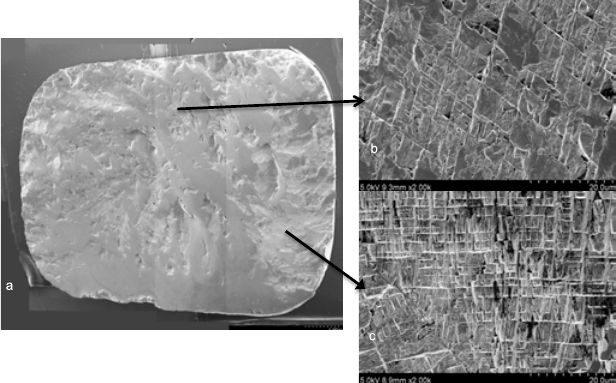
Figure 2 Examination of the stem fracture surface using a scanning electron microscope a) Surface of the fractured stem (Macroscopic image : scale 1.00 mm). b, c) Magnified microscope images. The arrowhead shows the